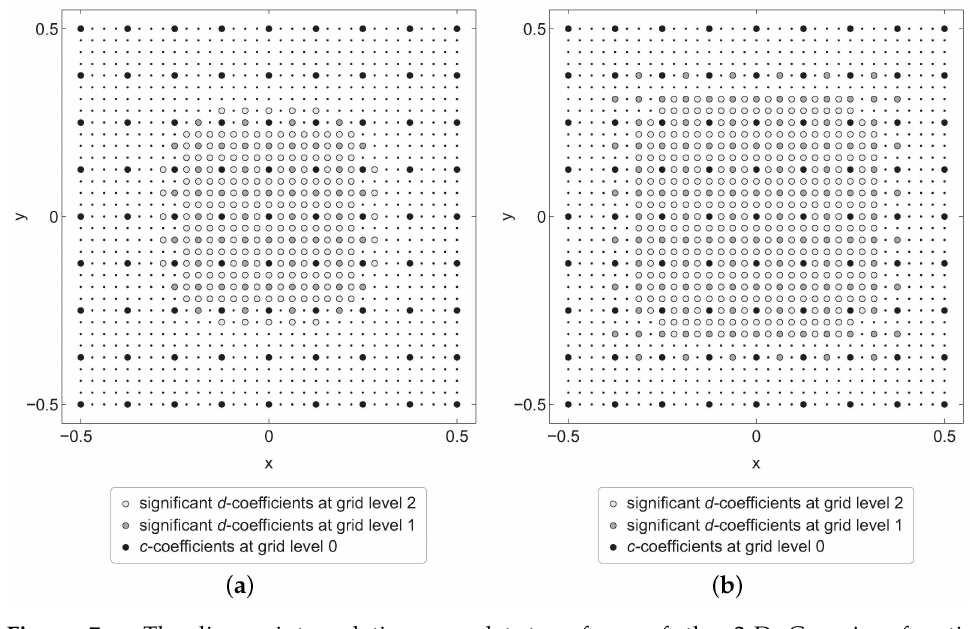
Figure 7. The linear interpolating wavelet transform of the 2-D Gaussian function − x 2 + y 2 f ( x , y ) = e 2 ( 0.07 ) 2 : ( a ) the initial mask M after the wavelet transform and ( b ) the extended mask M used for mesh adaptation.